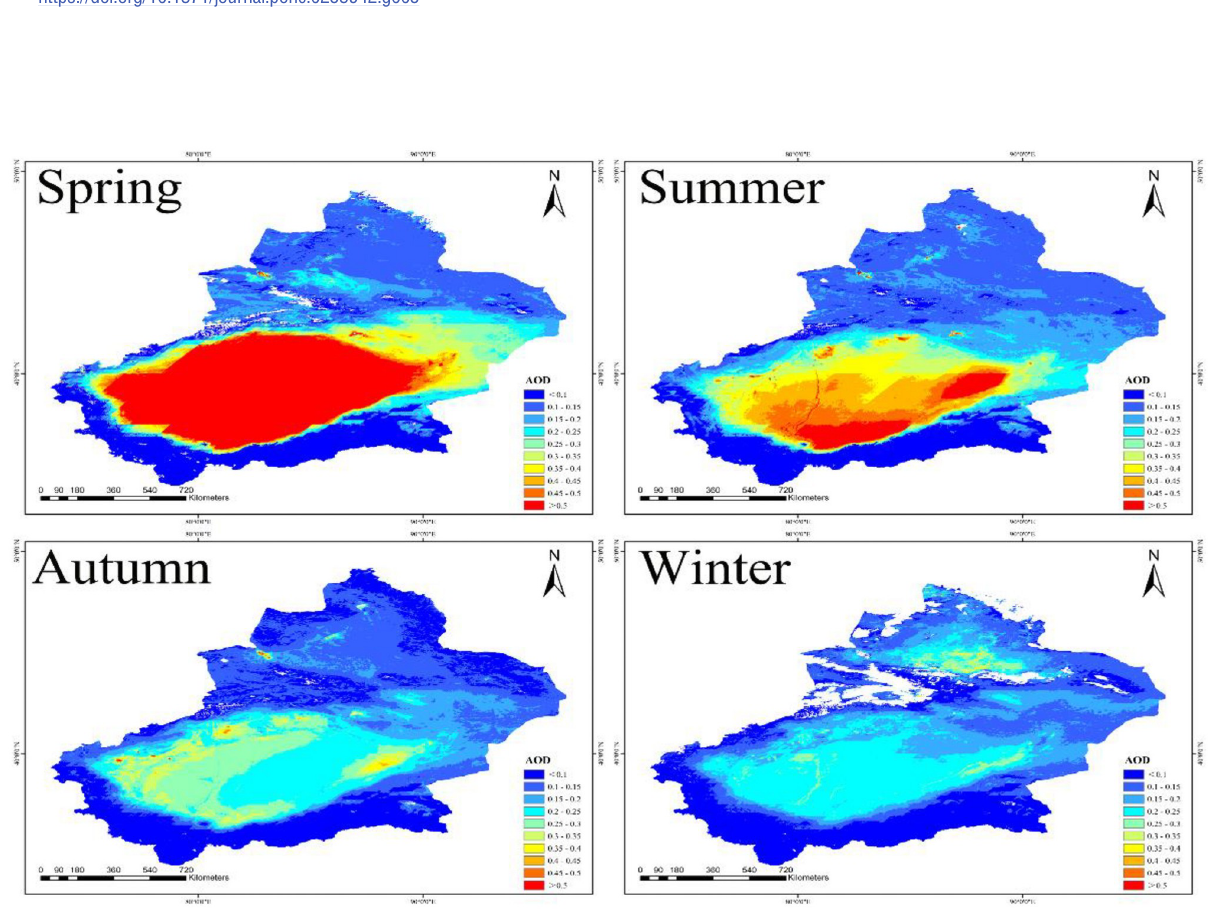
Fig 6. Seasonal mean AOD distribution (The red is the highest value and dark blue represents the lowest value. Map is created using ArcGIS version 10.3. Xinjiang Uygur Autonomous Region is downloaded from The Gateway to Astronaut Photography of Earth website (https://eol.jsc.nasa. gov/SearchPhotos/). Map credit: Jinglong